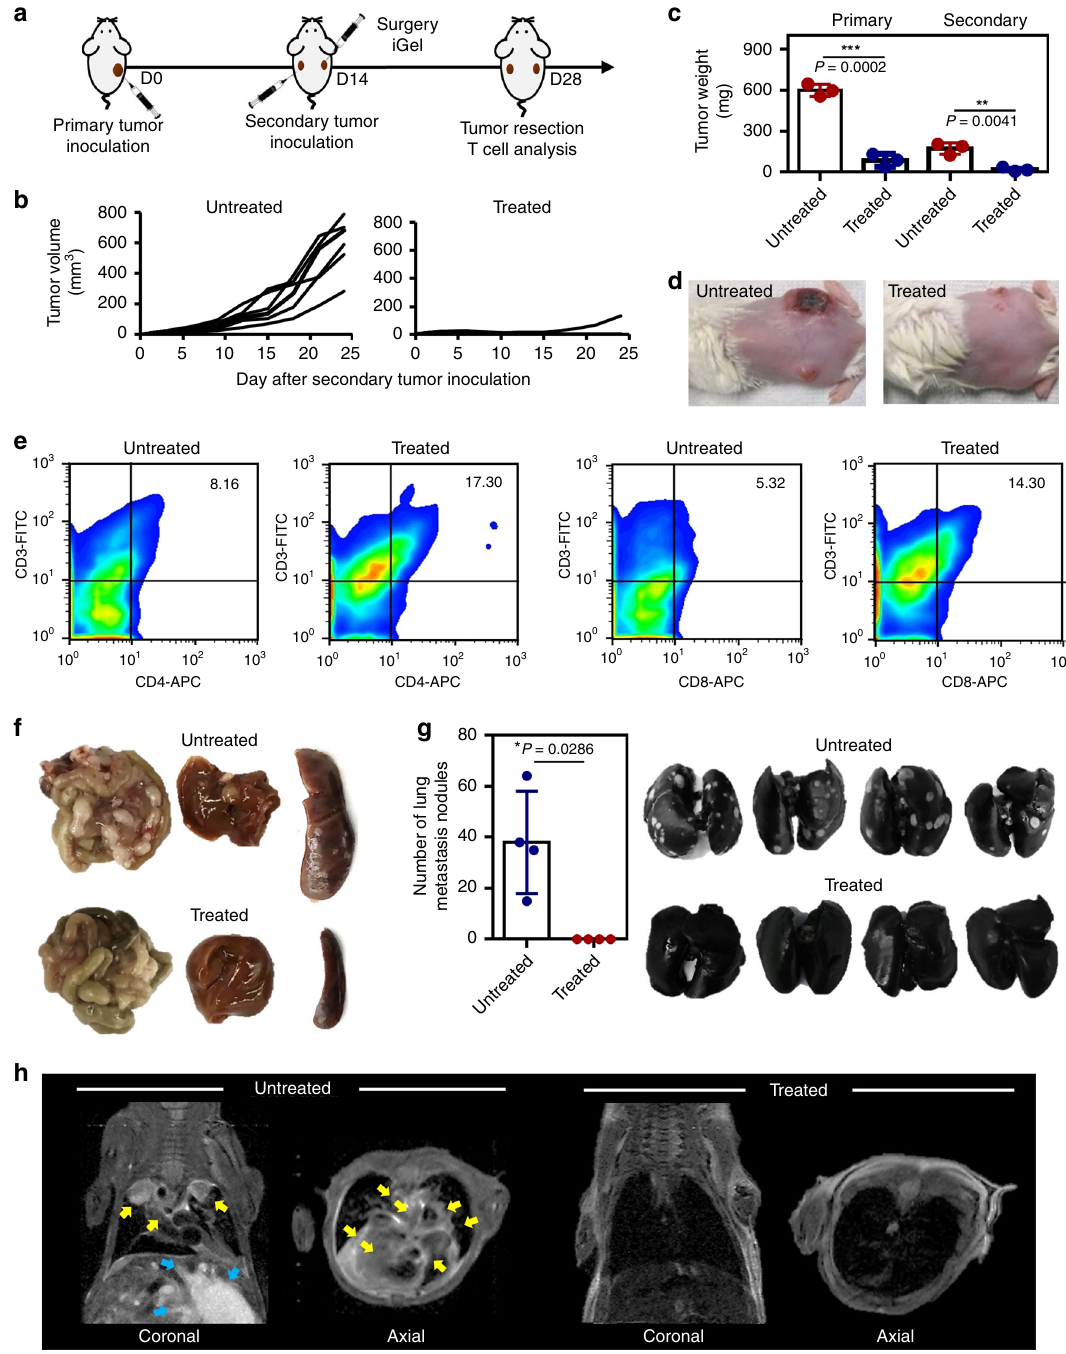
Fig. 6 Generation of a systemic antitumor immune response by iGel treatment. a Schedule for the systemic antitumor immune response test ( n = 9, 6 mice were used for b and 3 mice were used for c – e ). b Secondary tumor growth curves. c Tumor weight and d representative photographs of mice on day 14 after treatment. Statistical analysis was performed by Student ’ s t -test. e Percentages and representative dot plots of CD4 + and CD8 + T cells in secondary tumors of untreated and treated mice. f Representative images of the intestine, liver, and spleen collected from mice 21 days after surgery. g Images of lungs collected from mice 21 days after surgery. Number of metastatic lung nodules ( n = 4). Statistical analysis was performed by Mann – Whitney test. h MRI scans images showing tumor metastasis. Yellow arrows in coronal and axial images indicate the tumors in lung. Blue arrows in coronal image of untreated group indicate tumors in other body parts. Another hyper-intense white signal that is not indicated by arrows is related to massive ascites, which re fl ected the aggressive features of peritoneal spread tumor ( n = 3). The results are representative of one of two independent experiments. Source data